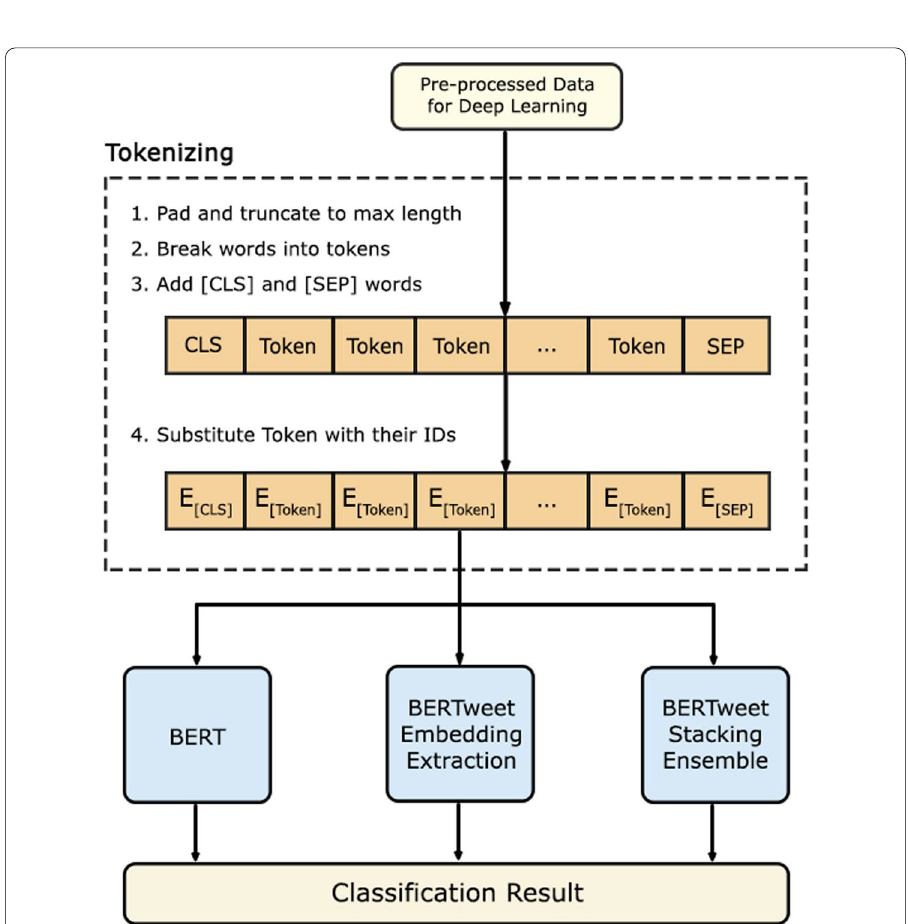
Fig. 5 Deep Learning tokenization